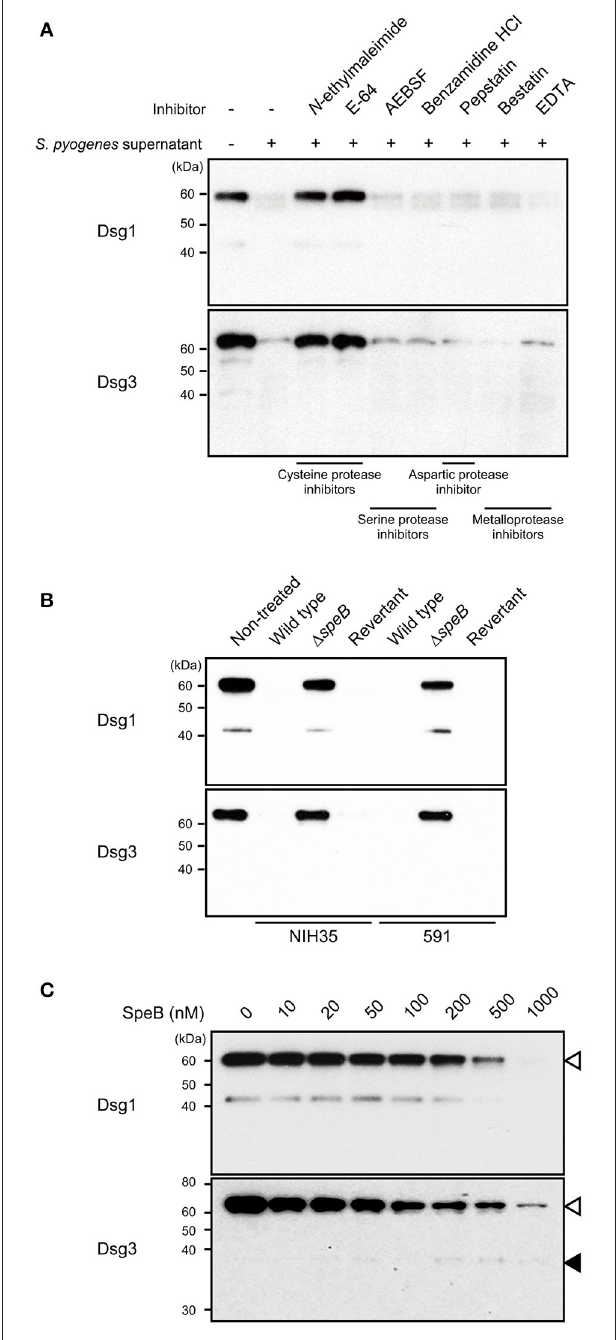
FIGURE 2 | SpeB is a bacterial determinant for cleavage of desmogleins. (A) Culturesupernatantfrom S.pyogenes strain591waspretreatedwithvarious types of protease inhibitors at room temperature for 30min, then incubated with Dsg1 or Dsg3 recombinant protein at 37 ◦ C for 3h. (B) Recombinant desmogleins were separately treated with culture supernatants from S. pyogenes strains at 37 ◦ C for 3h. An in-frame speB deletion mutant and its revertant strain with a background of NIH35 or 591 were employed for analysis. (C) Dsg1 and Dsg3 recombinant proteins were separately incubated with various concentrations of recombinant SpeB at 37 ◦ C for 3h, then cleavage of desmogleins was detected by western blot analysis. White and black arrowheads indicate the full-length band and cleavage fragment,